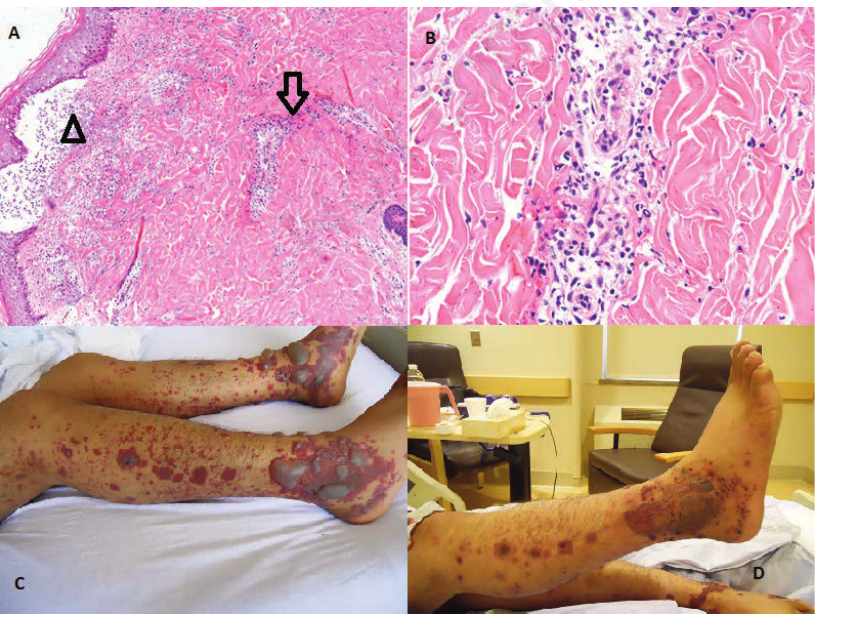
Figure 1. A) Skin with epidermal spongiosis, subepidermal vesicles, pustular formation (arrowhead), and leukocytoclastic vasculitis (arrow); B) high power view shows infiltra- tion of inflammatory cells, predominantly neutrophils, which causes vascular damage; C) gross image of skin findings on admission; D) gross image of skin findings 3 days after the initiation of